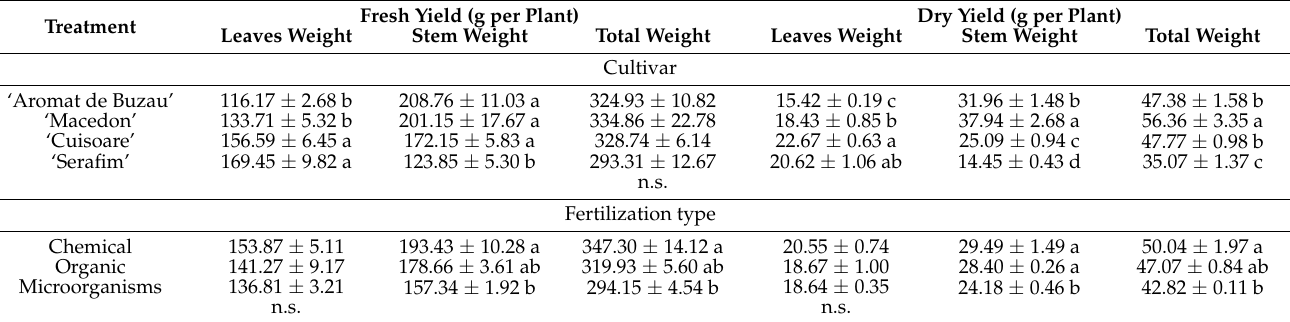
Table 3. Influence of cultivar and fertilization type on basil yield characteristics.